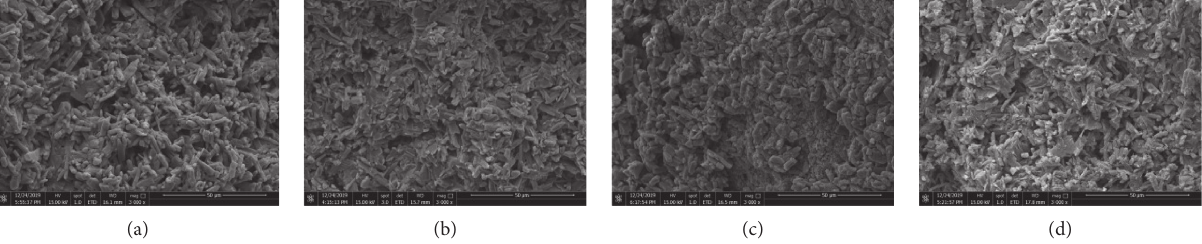
Figure 15: Scanning results at 3000x magnification. (a) Natural. (b) 45 ° C dehydration. (c) Water saturation. (d) High-temperature